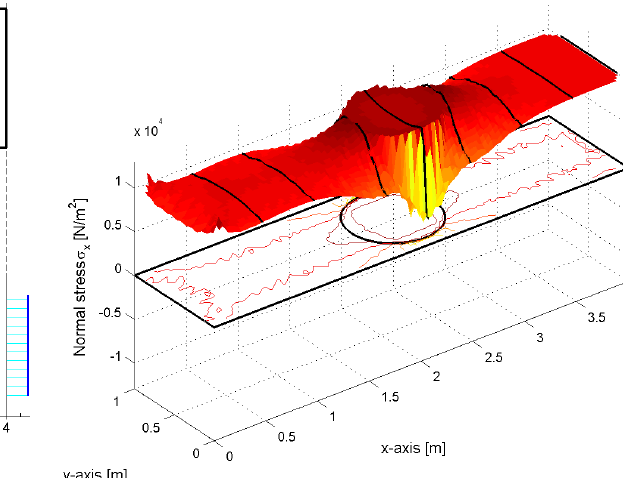
Figure 17: Plot of the normal stresses σ x along some significant cross-sections (unit of measurement of σ x : N / m 2 , amplification factor of σ x : k = 1.5567 · 10 −5 ).